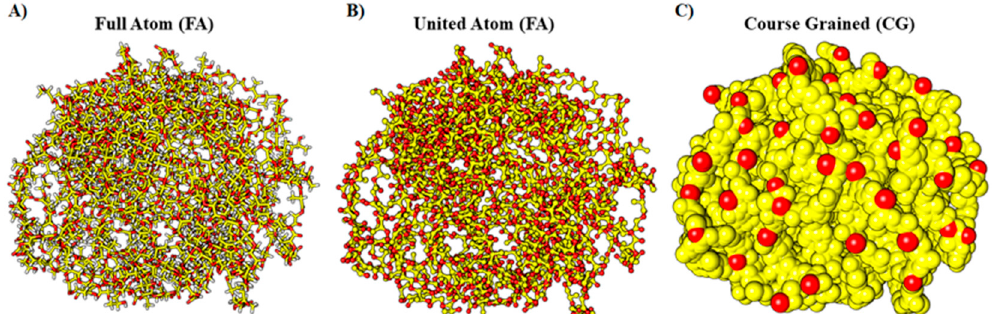
Figure 17. Representations of PLA nanoparticles using ( A ) full atoms (FA), ( B ) united atoms (UA), and ( C ) course grained (CG) methods.